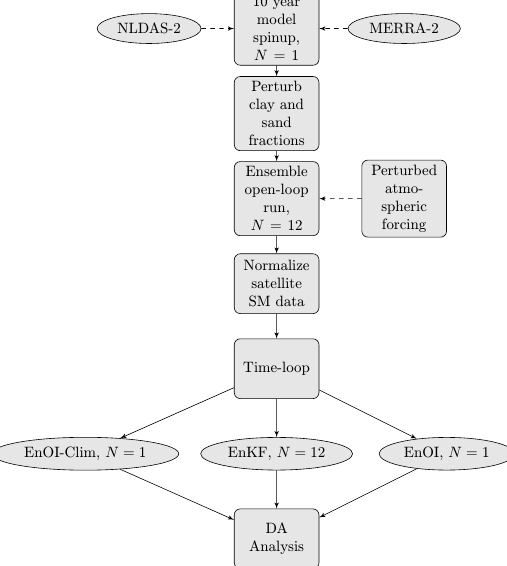
Figure 1. The experiments are setup using a 10 year spinup for the land surface initial conditions. From the initial state, we perform three different experiments: (i) the EnKF with evolving background error; (ii) the EnOI using the background error from the ensemble open-loop run, and (iii) the EnOI using a climatological background error as the ensemble